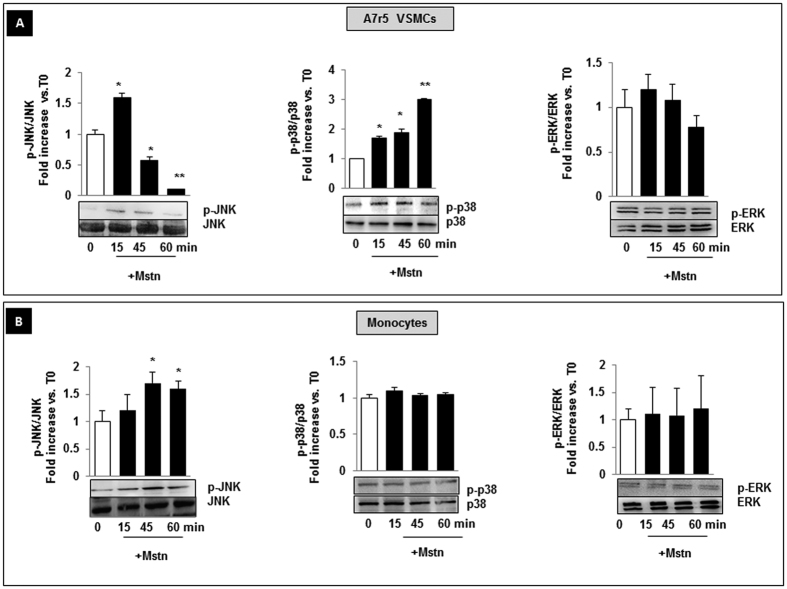
Effect of Myostatin (Mstn) on MAPKinase phosphorylation in A7r5 VSMCs and human freshly isolated monocytes.Cells were exposed to Mstn for 15, 45, 60 minutes and cell lysates were analyzed by western blot. Membranes were stripped and reprobed for non-phosphorylated MAPKs. Mstn induces phosphorylation of JNK and p38 in A7r5 cells (A), and of JNK in monocytes (B). All results represent mean ± SEM obtained from three independent experiments. *p < 0.05, **p < 0.01 vs T0. p-JNK = Phosphorylated JNK, p-ERK = Phosphorylated ERK, p-p38 = Phosphorylated p38.